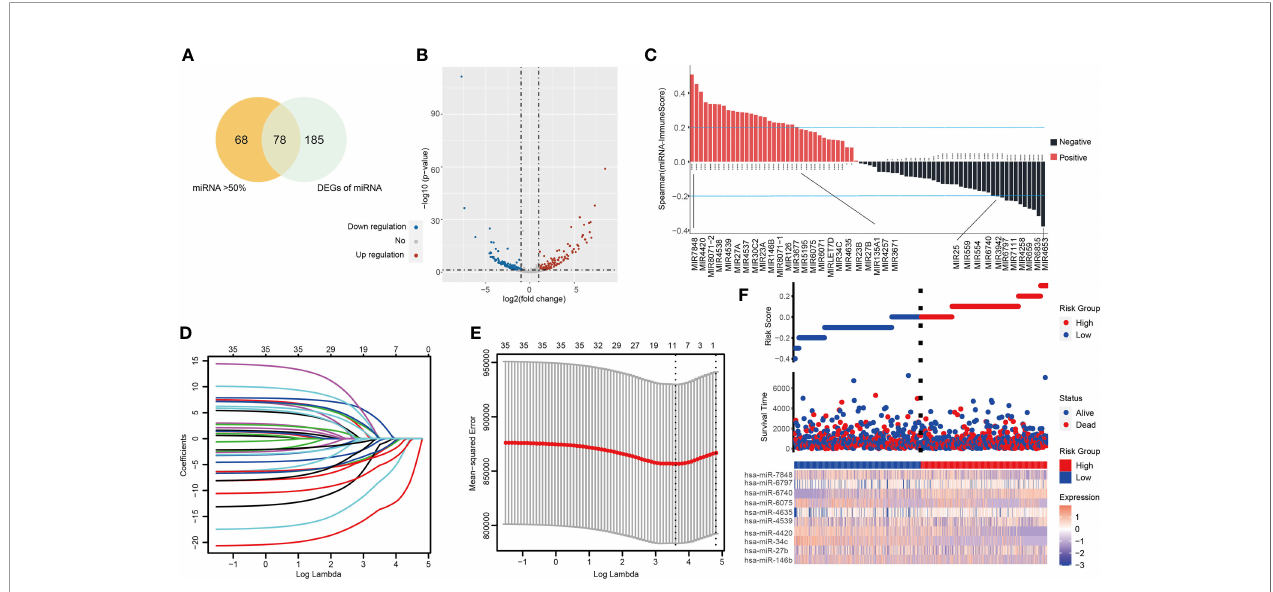
FIGURE 1 | The tumor-in fi ltrating immune-related miRNA signature (TIM-Sig). (A) miRNAs expressed in more than 50% of the tumor samples and are differentially expressed. (B) Volcano plot of 263 identi fi ed differential expression miRNAs. The cutoffs were set as a log2(fold-change) > 1.0 or < – 1.0 and p-value < 0.05. (C) miRNAs expression associated with immune score, as shown by Spearman correlation analysis. (D, E) The LASSO regression method was carried out to identify the 10 critical miRNAs associated with tumor immune in fi ltration. (F) The log-rank test and univariate Cox analysis were used to process data. Patterns of miRNAs expression and proportion of high-and low-risk patients in the veri fi cation